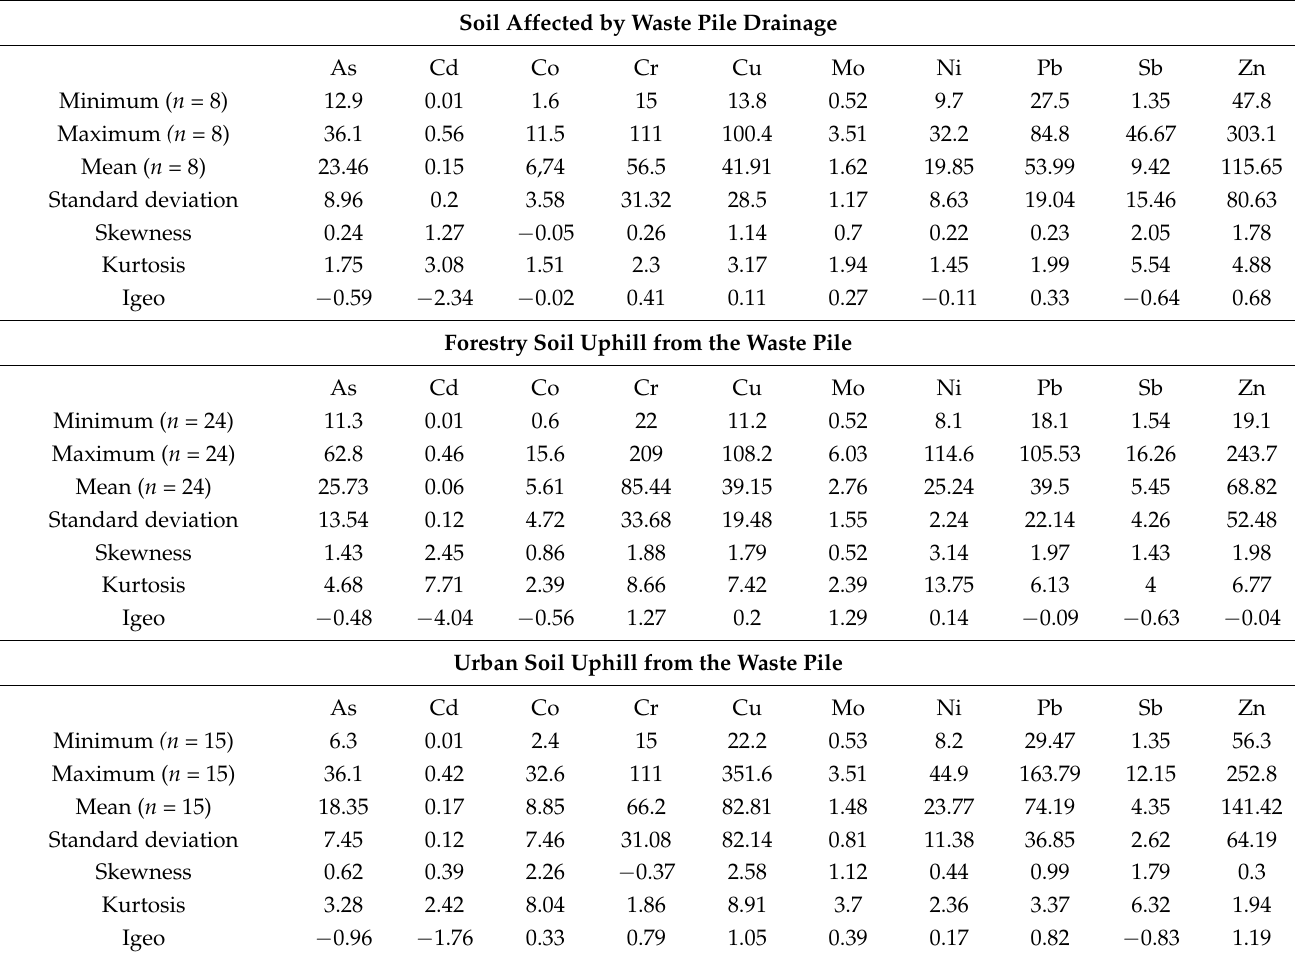
Table 3. Descriptive statistics for PTEs concentrations in the subsets of the studied soils (in mg kg − 1 ), according to the land use and the corresponding Igeo calculated considering the determined regional geochemical